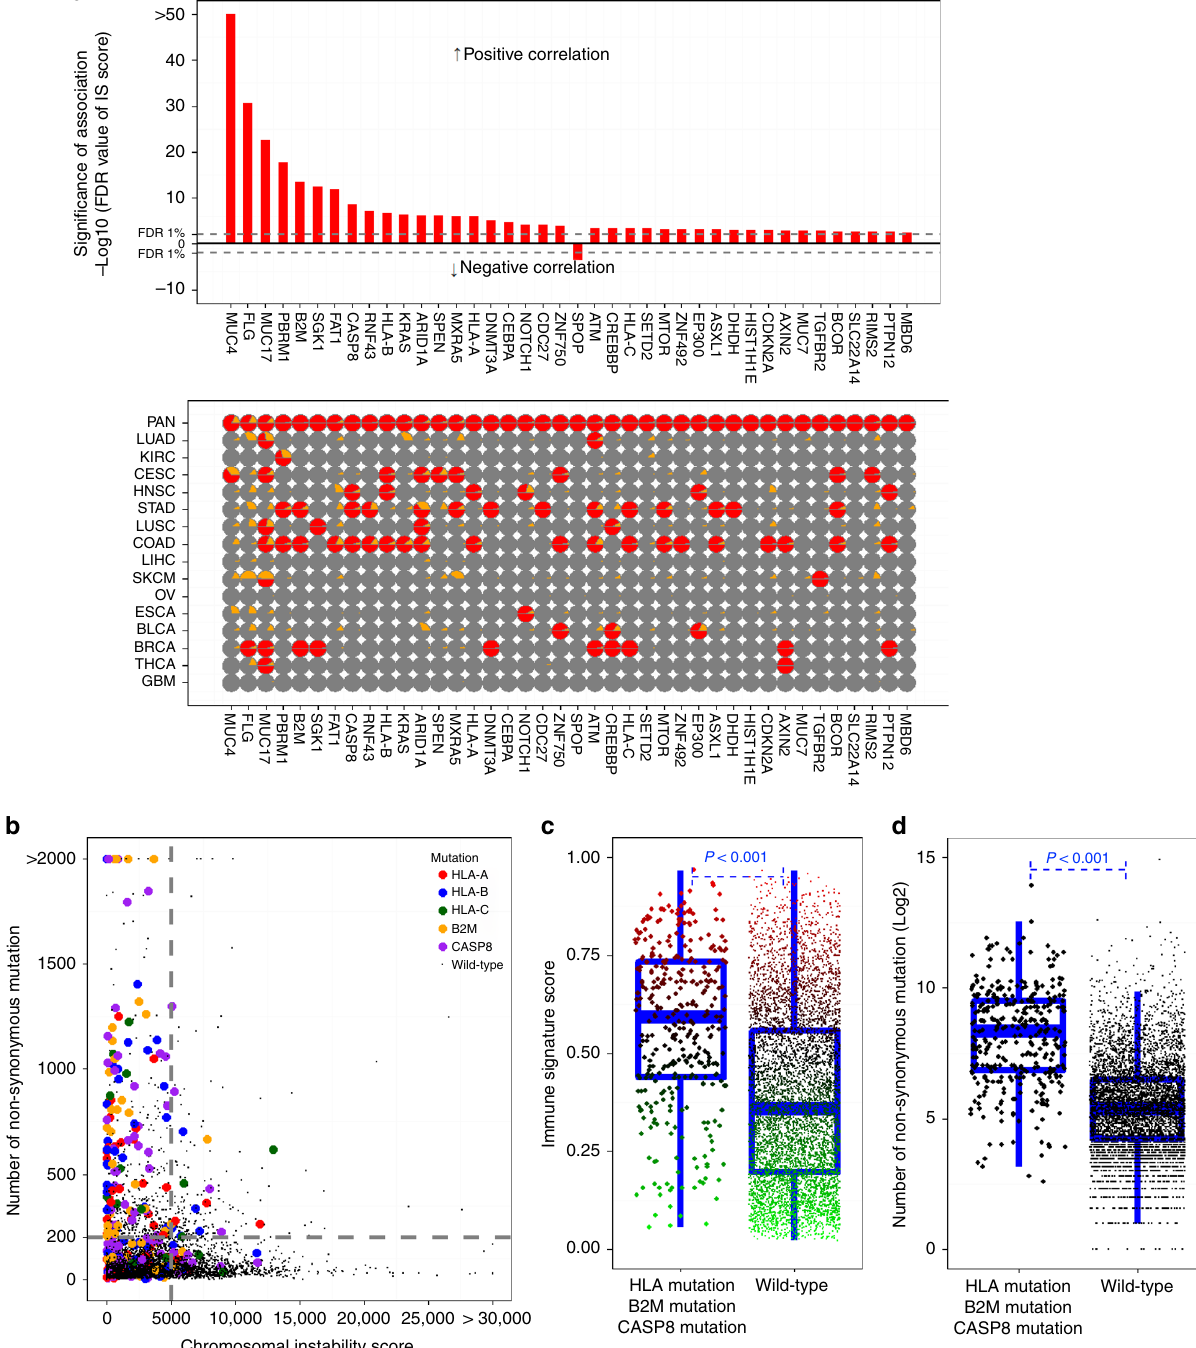
Fig. 6 Somatic mutations associated with immune signature scores. a Top: the signi fi cant pan-cancer-wide association of mutation rates with immune signature (IS) scores. Red bars represent signi fi cance (FDR) of association of mutation rate with IS score in each gene. Dashed line indicates 1% threshold of FDR. Bottom: the signi fi cance of association in each cancer type. Red or gray indicate signi fi cance or insigni fi cance, respectively, and yellow indicates the frequency of mutations in each gene. b Scatter plots between mutation rates and chromosomal instability scores in all tumors highlighted with mutations in HLA-A , HLA-B , HLA-C , B2M , and CASP8 . c , d IS score c and number of mutation d in tumors with and without mutations in HLA-A , HLA-B , HLA-C , B2M , and CASP8 . Blue lines in the box represent upper 75%, median, and lower 25% values of subtype. See also Supplementary Data identi fi ed as a pharmacodynamic marker for anti-CTLA-4 ther- and head and neck cancer. Furthermore, IS scores were sig- apy 55 . Third, most importantly, IS scores can identify responder ni fi cantly associated with expression of PD-1 and PD-L1 in patients with melanoma after treatment with ipilimumab 29 . TCGA data. Fifth, gene network analysis identi fi ed many pro- Forth, IS scores is signi fi cantly correlated with interferon-gamma in fl ammatory cytokines as activated upstream regulators in score that is predictive markers for anti-PD-1 therapy in gastric responder patients while it identi fi ed anti-in fl ammatory cytokines